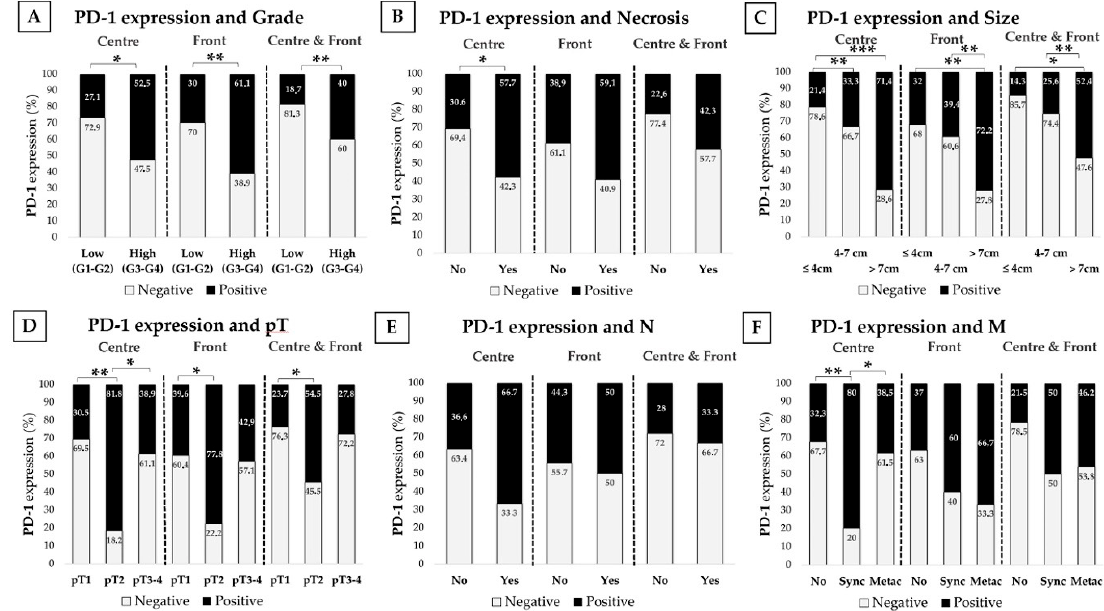
Figure 3. Immunohistochemical PD-1 staining according to CCRCC aggressiveness. PD-1 immunostaining at the tumor center, infiltrating simultaneously at both areas depending on the histological grade ( A ), tumor necrosis ( B ), diameter ( C ), local invasion or pT ( D ), lymph node metastasis or N ( E ) and distant metastasis or M ( F ). PD-1 staining intensity was scored as negative or positive. Chi-Square test * p < 0.05; ** p < 0.01, *** p < 0.001.